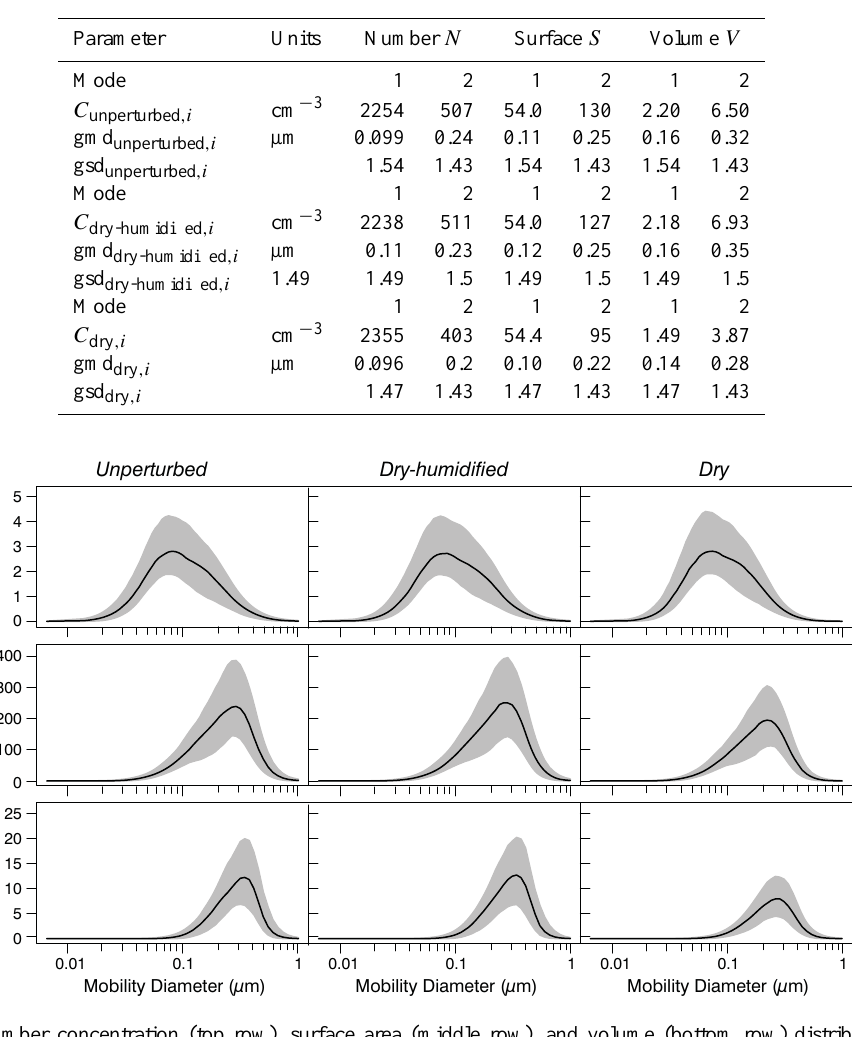
Table 2. Parameters describing two-mode distributions of number concentration, surface area, and volume for the unperturbed ( C unperturbed ,i ) , dry-humidified ( C dry-humidified ,i ) , and dry states ( C dry ,i ) .